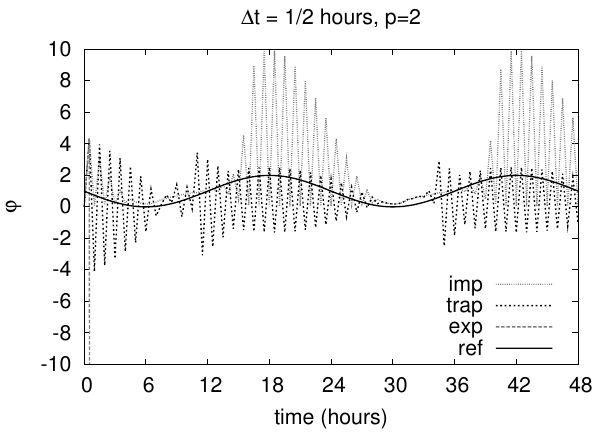
Fig. 1. Numerical solutions of Equation 1 with implicit (dotted), trapezoid (short dash) and explicit (long dash) schemes for exponent p = 2 and time-step ∆ t = 0 . 5 hours. Function D ( t ) is also shown (full line) for reference.